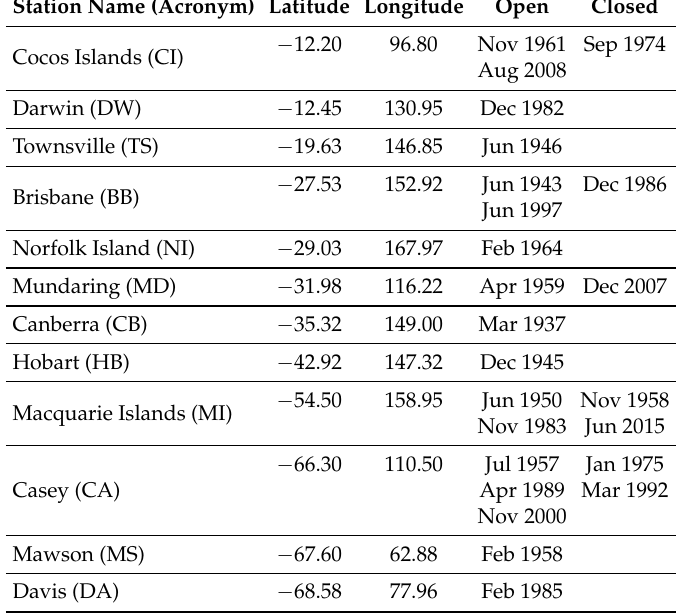
Figure 1. Distribution of the 12 ionosonde stations in the Australian region. Table 1. Australian ionosonde stations and their geographic